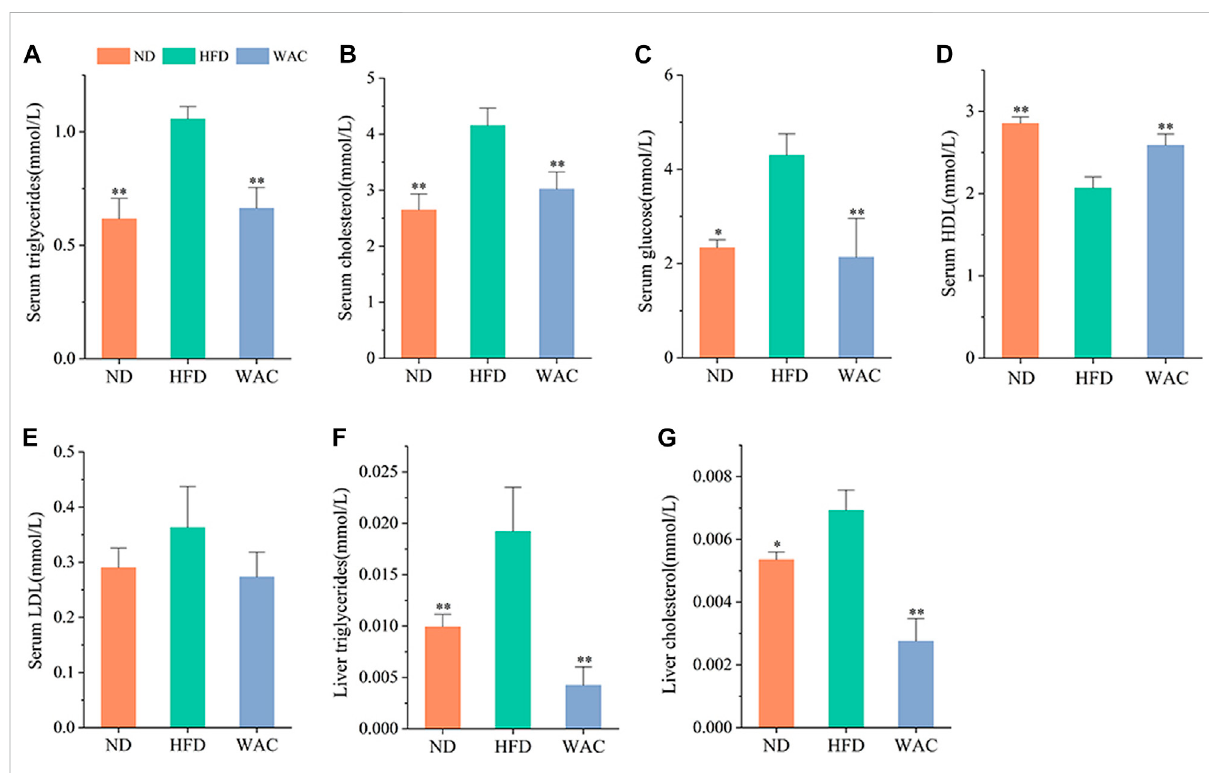
FIGURE 3 Effect of WAC on metabolic disorders in HFD-induced NAFLD mice. (A) Serum triglyceride levels. (B) Serum cholesterol levels. (C) Serum glucose levels. (D) Serum HDL levels. (E) Serum LDL levels. (F) Liver triglyceride levels in mice. (G) Liver cholesterol levels in mice. Compared with HFD, * indicates p < 0.05 and ** indicates p <